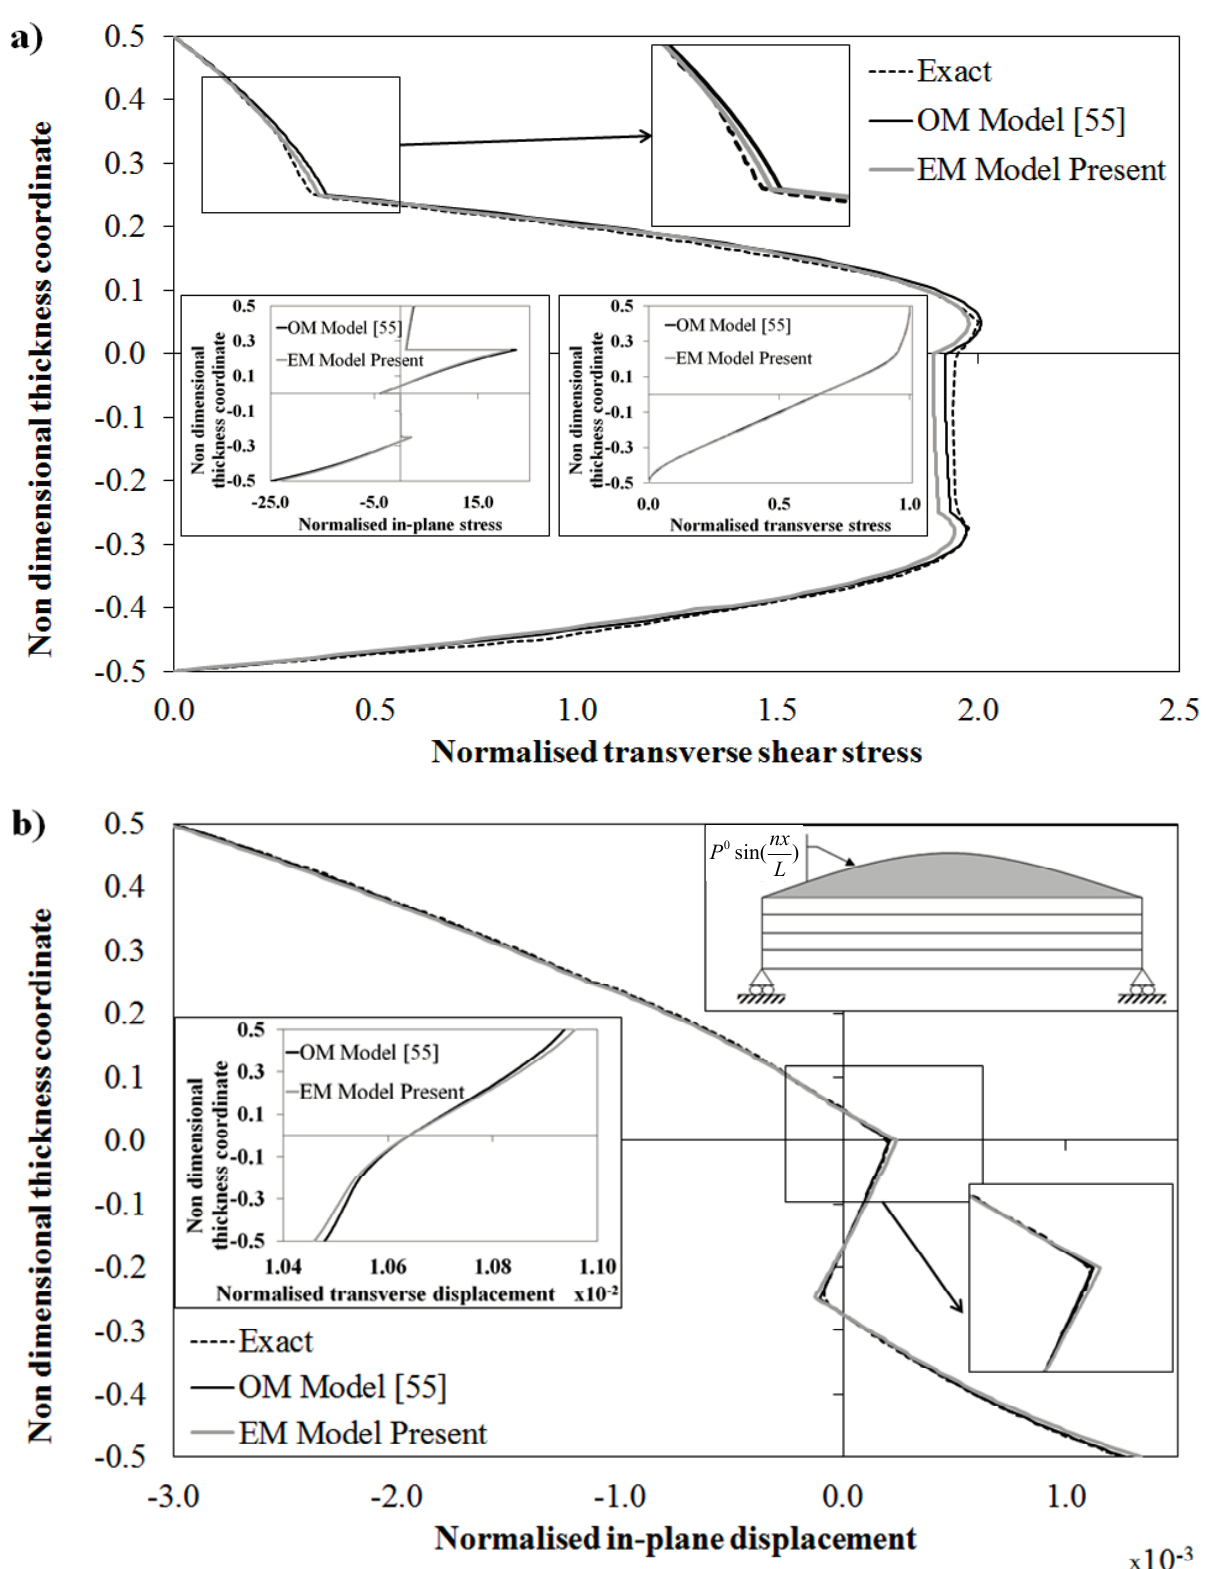
Figure 3. Exact solution and through-the-thickness distribution of: ( a ) normalized transverse shear stress; and ( b ) normalized in-plane displacement by the OM Model [55] and by the present EM Model for a laminated